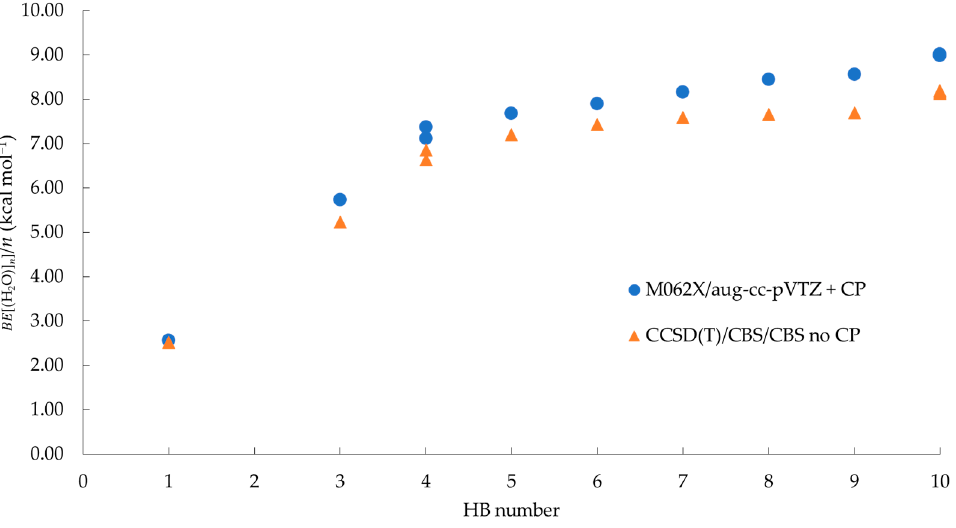
] / n in kcal mol − 1 vs. the number of n